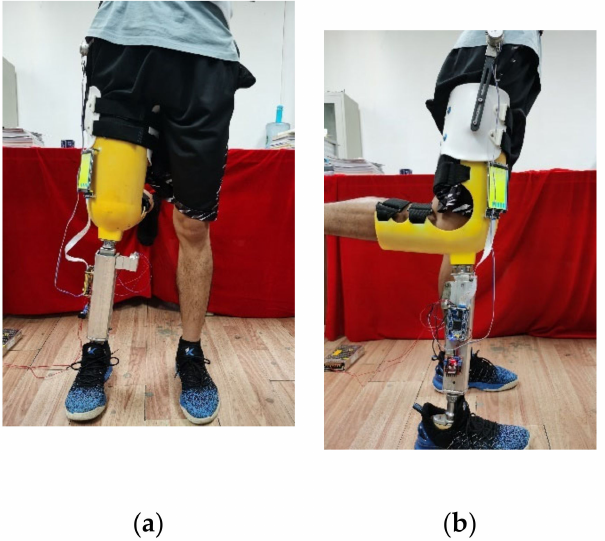
Figure 18. MR prosthesis test system.